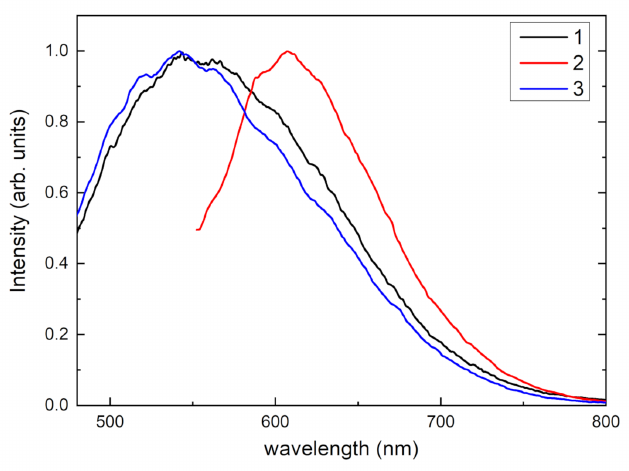
Figure 9. Photoluminescence spectra of tinaksite under 405 nm ( curve 1 ) and 532 nm ( curve 2 ) excitations and tokkoite under 405 nm excitation ( curve 3 ) at 77